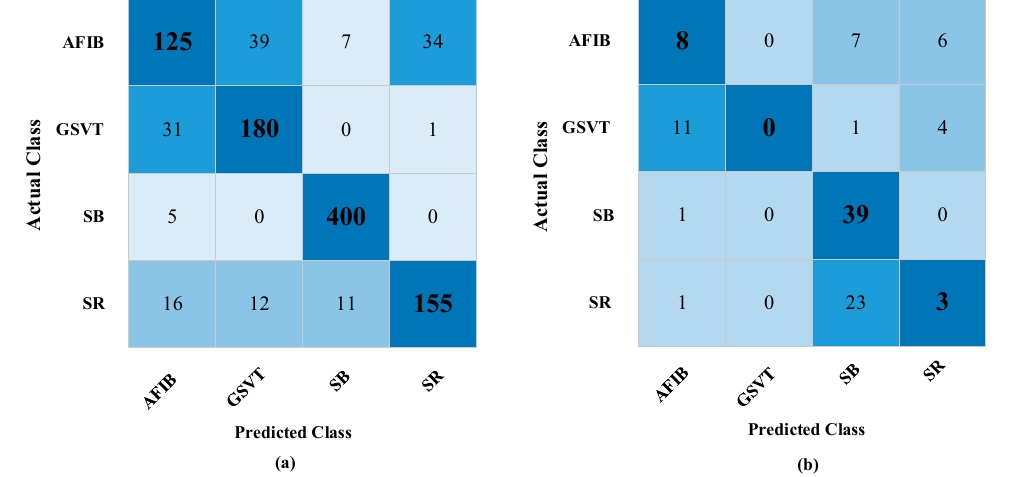
Figure 6. Confusion matrices obtained with quantum support vector machine (QSVM) classifier: ( a ) highest and ( b ) lowest accuracy. Table 4. Performance metrics of QSVM with the highest accuracy and lowest